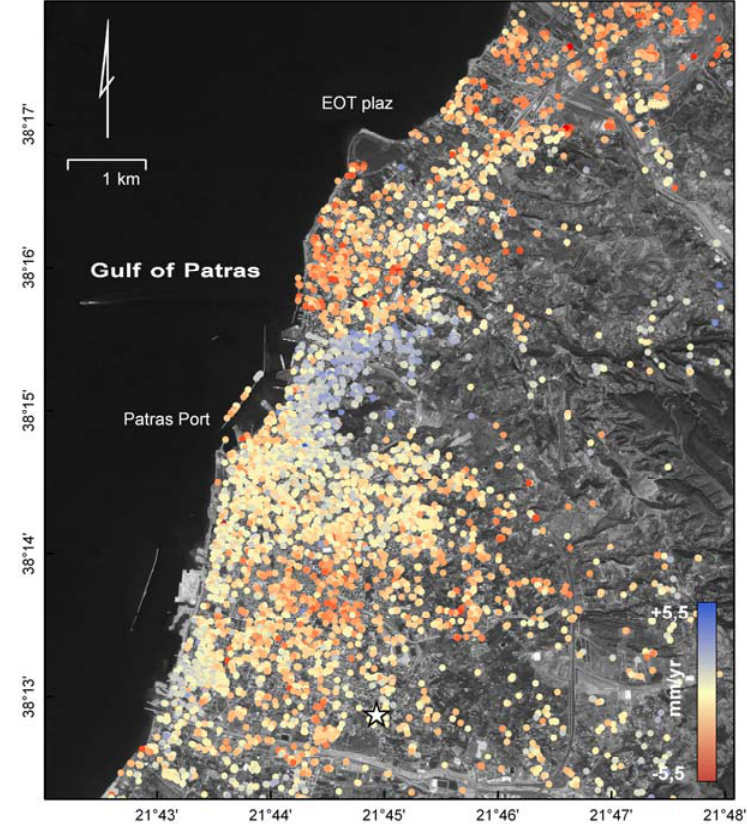
Figure 4. Linear component of ground deformation obtained by IPTA over Patras city. Point targets are plotted on a Panchromatic Landsat–7 ETM+ image. The star on the image refers to the location of the reference point.